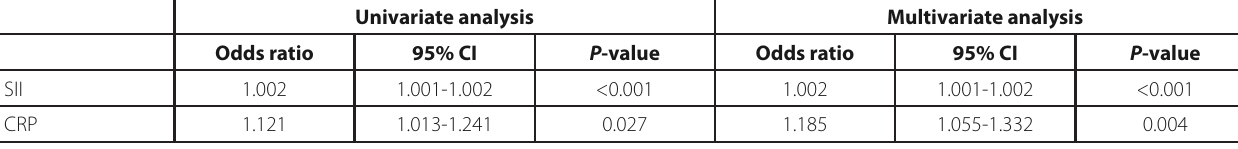
Table 5. Univariate and multivariate logistic regression analyses of independent parameters for atrial